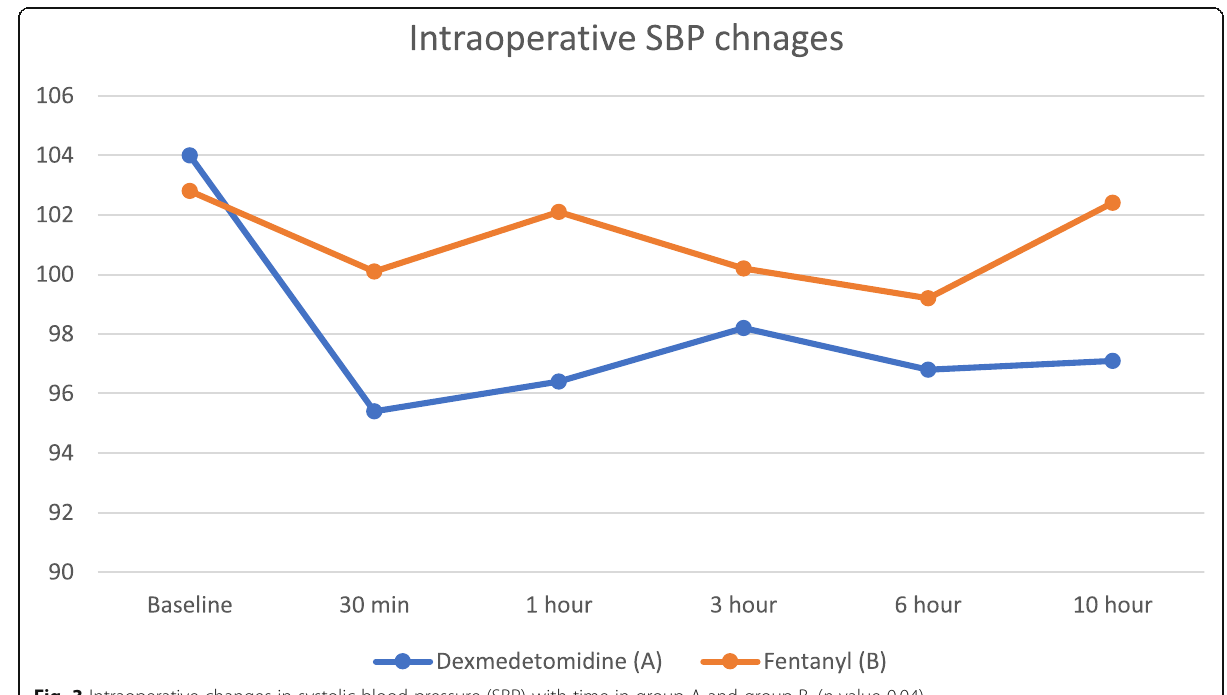
Fig. 3 Intraoperative changes in systolic blood pressure (SBP) with time in group A and group B. ( p value 0.04)